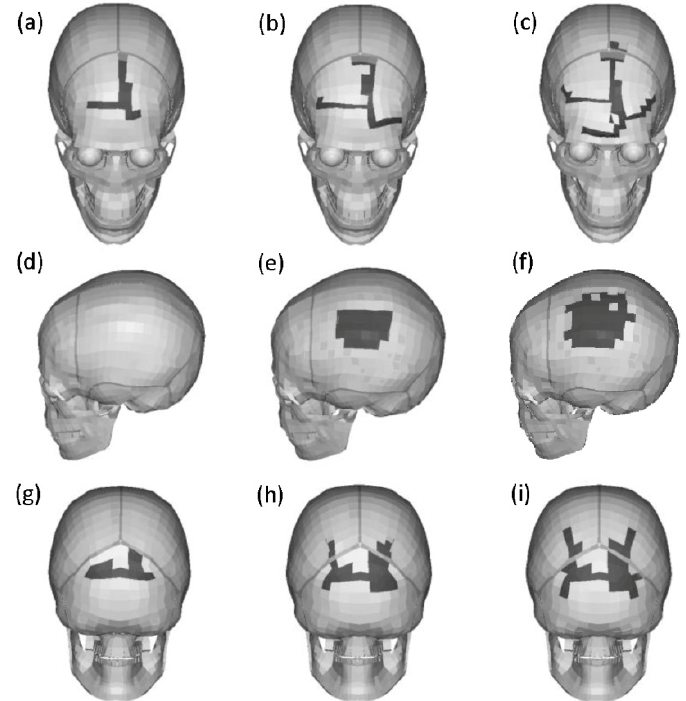
Figure 8. Fracture patterns of head fracture model for three locations under three impact velocities. ( a–c ) Frontal impact, ( d–f ) parietal impact, and ( g–i ) occipital impact; the impact velocities are 25, 35, 45 km/h from left to right, respectively; the skull fracture is represented in black.